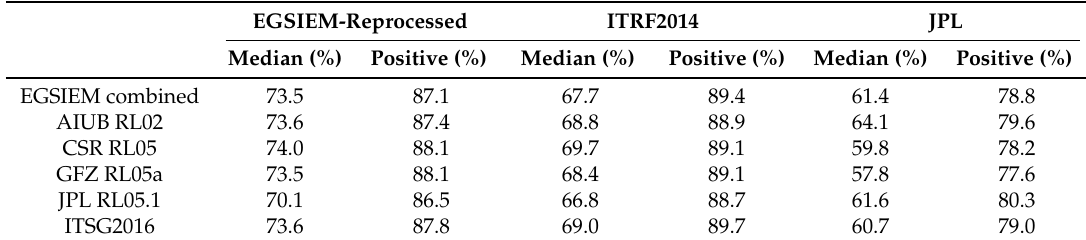
Figure 5. WRMS reduction at the annual signal over 928 GNSS stations using the ITRF2014 residuals. GRACE gravity solutions up to their full spectrum are used to compute the displacements. Table 2. Median and positive WRMS reductions between six GRACE products and three GNSS datasets at the annual signal level. Note that the table cannot serve as comparison among the three GNSS datasets as different numbers of stations are